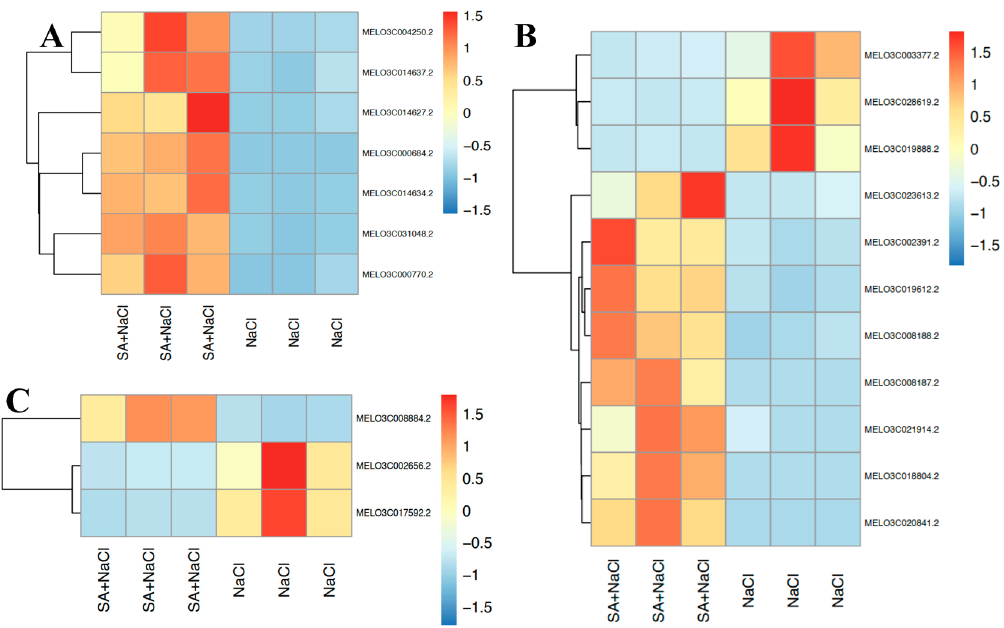
Figure 3. Heatmap showing the DEGs involved in different pathways in melon mediated by SA under salt stress. The colored bars represent the value (log 2 (fold change)) of the change in gene expression of the different treatments. Red represents up-regulated DEGs, and blue represents down-regulated DEGs. ( A ) Lipid metabolism; ( B ) biosynthesis of secondary metabolites; ( C ) signal transduction.